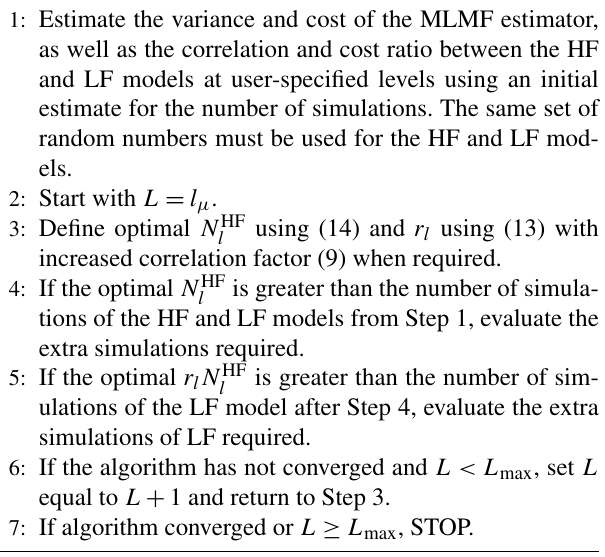
Algorithm 1 Multilevel multifidelity Monte Carlo